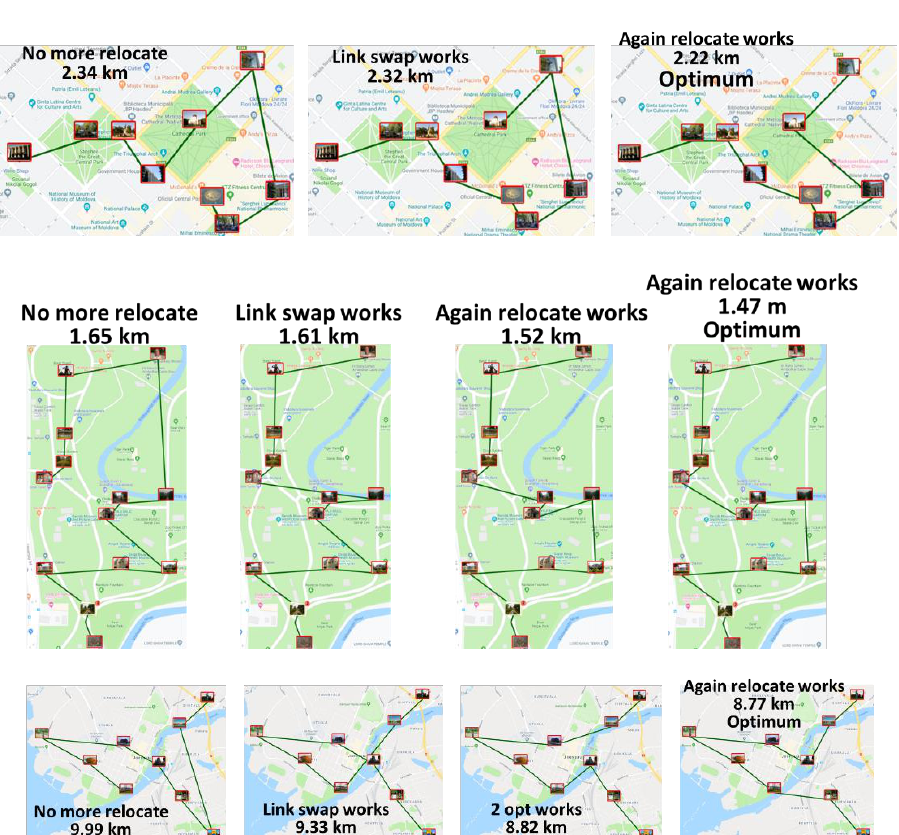
Figure13. Asingleoperatorcanre-workafterbeingstuckwiththehelpofotheroperators’improvement. Figure 13. A single operator can re-work afte r being stuck with the help of other operators’ improvement.